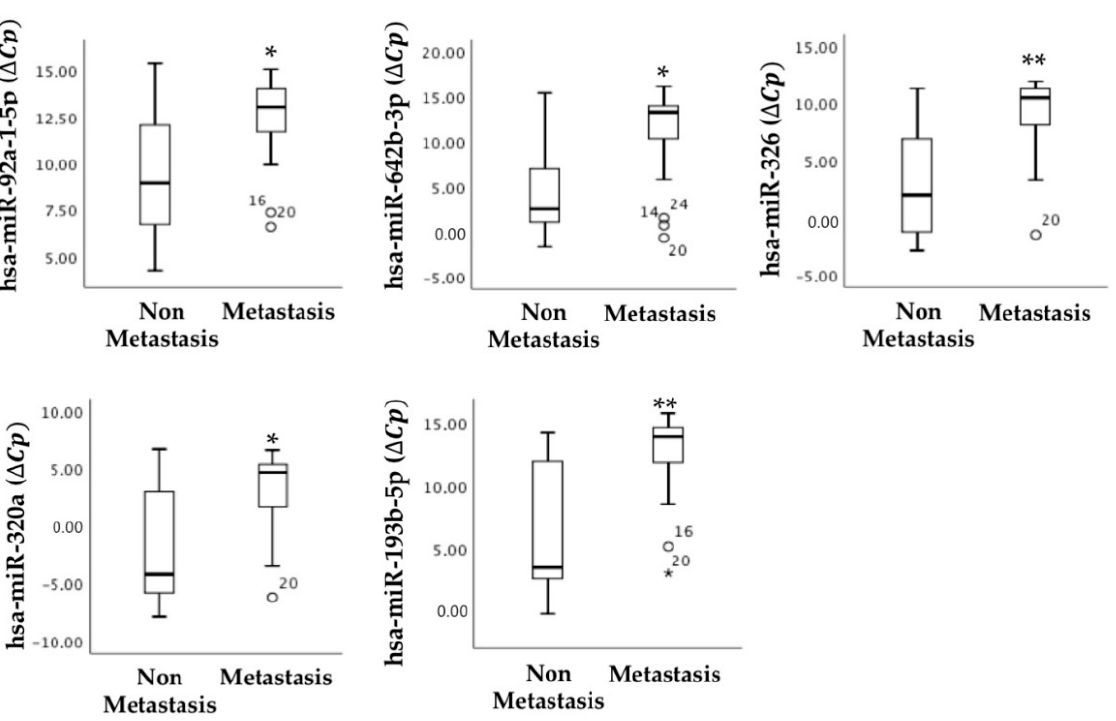
Figure 5. miRNAs determined in primary tumors associated with metastasis. Statistical association of selected miRNAs and tumor metastasis was determined by qRT-PCR in the primary tumors (non-metastasis, n = 11; metastasis, n = 21). miRNA levels are expressed as the delta-crossing threshold (DCT); the mean of miR-103a-3p Cq and miR-30c-5p Cq was used as a normalizer Cq. Only miRNAs showing a statistically significant association between the two represented categories are shown. Data are presented as the median and interquartile range, with * p < 0.05, ** p < 0.01, ◦ outliers